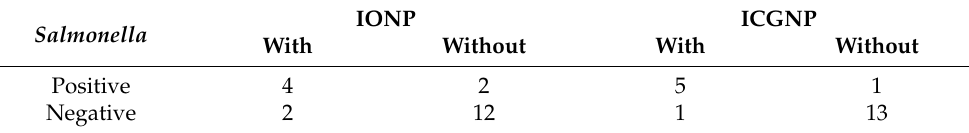
Table 1. Two-tail Fisher’s test for IONPs and ICGNPs. Table 1. Two- tail Fisher’s te st for IONPs and ICGNPs.